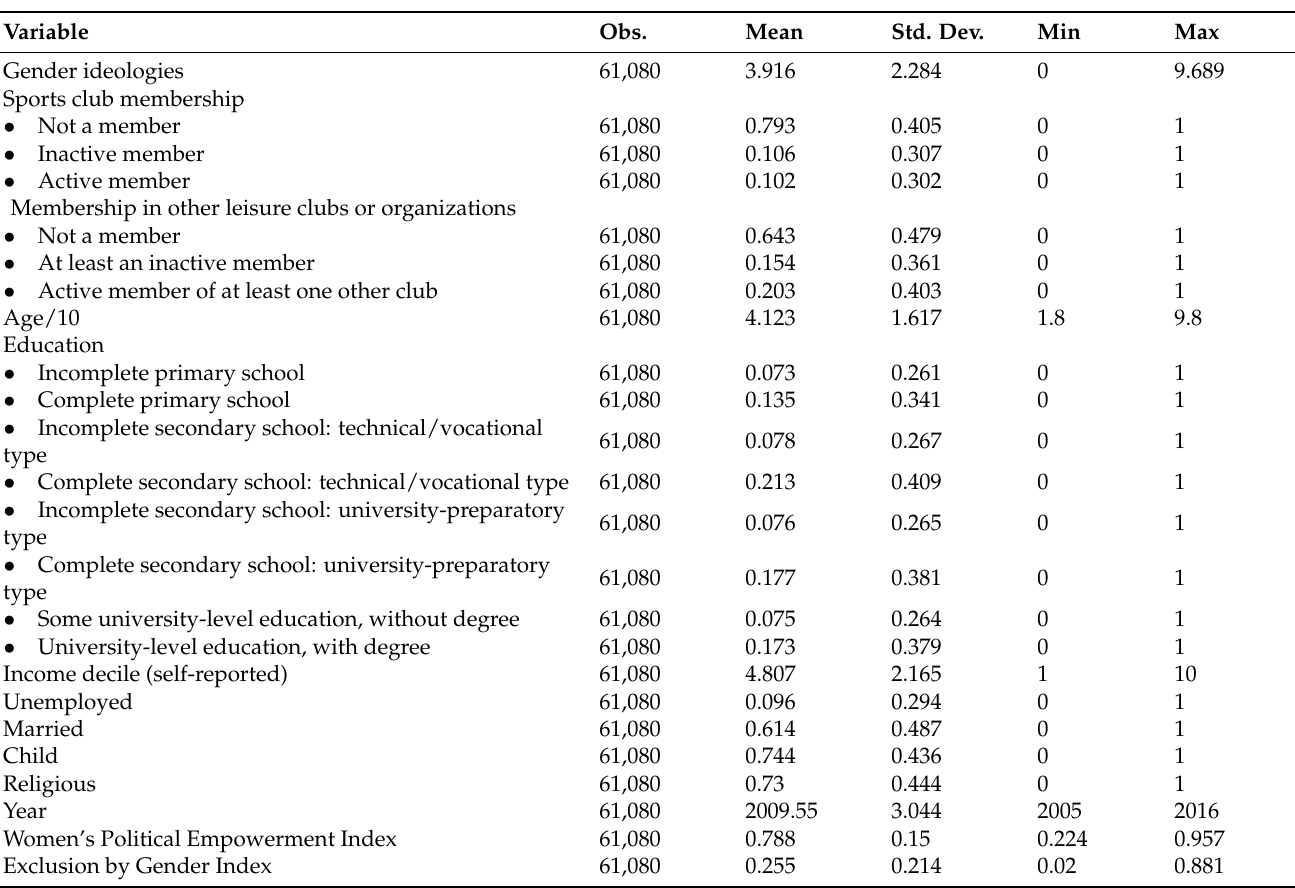
Table 2. Summary statistics for